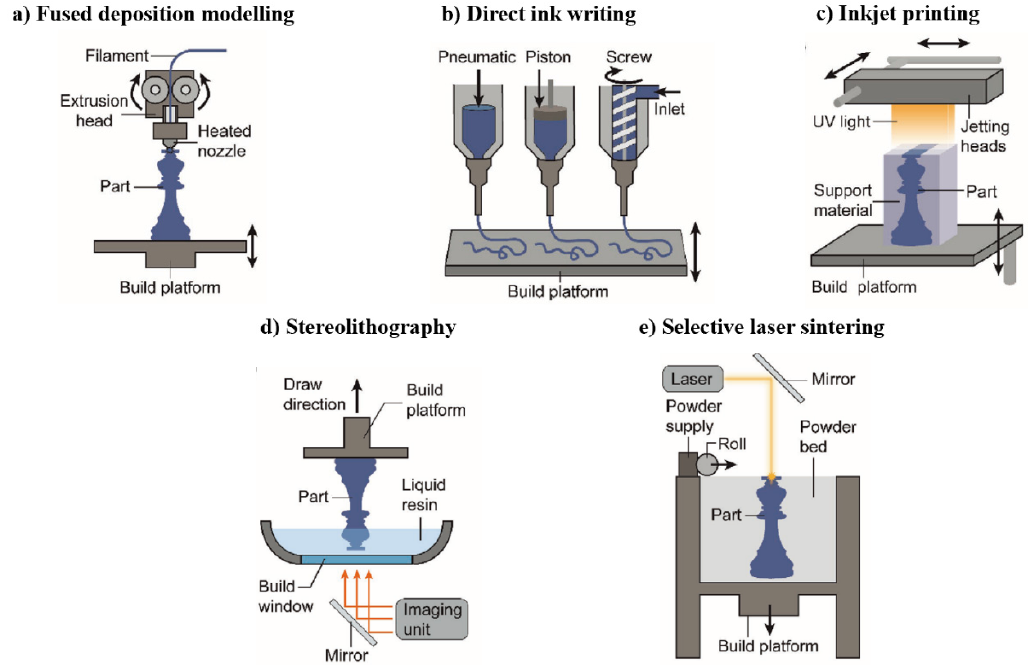
Figure 1. 3D printing method. ( a ) Fused deposition modelling; ( b ) Direct ink writing; ( c ) Inkjet printing; ( d ) Stereolithography; ( e ) Selective laser sintering. Reproduced with permission from ref. [27]. Copyright 2018, John Wiley and Sons.